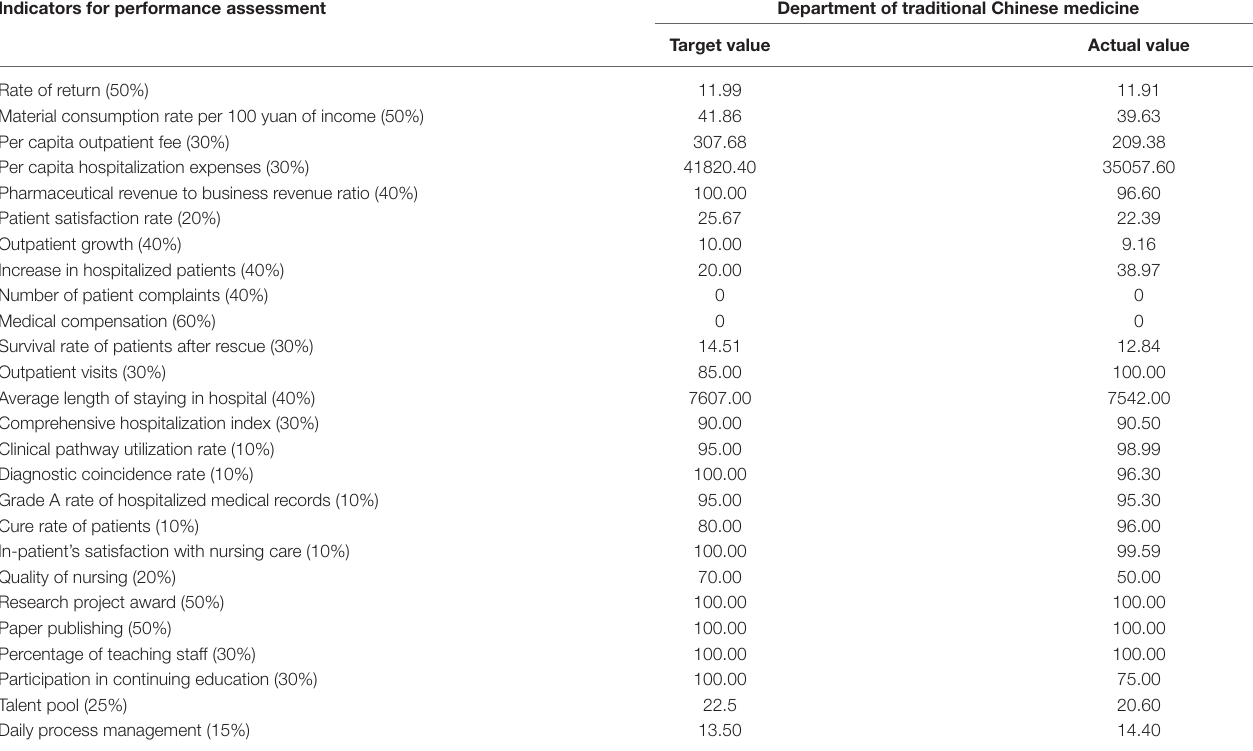
TABLE 9 | Performance evaluation of each department.